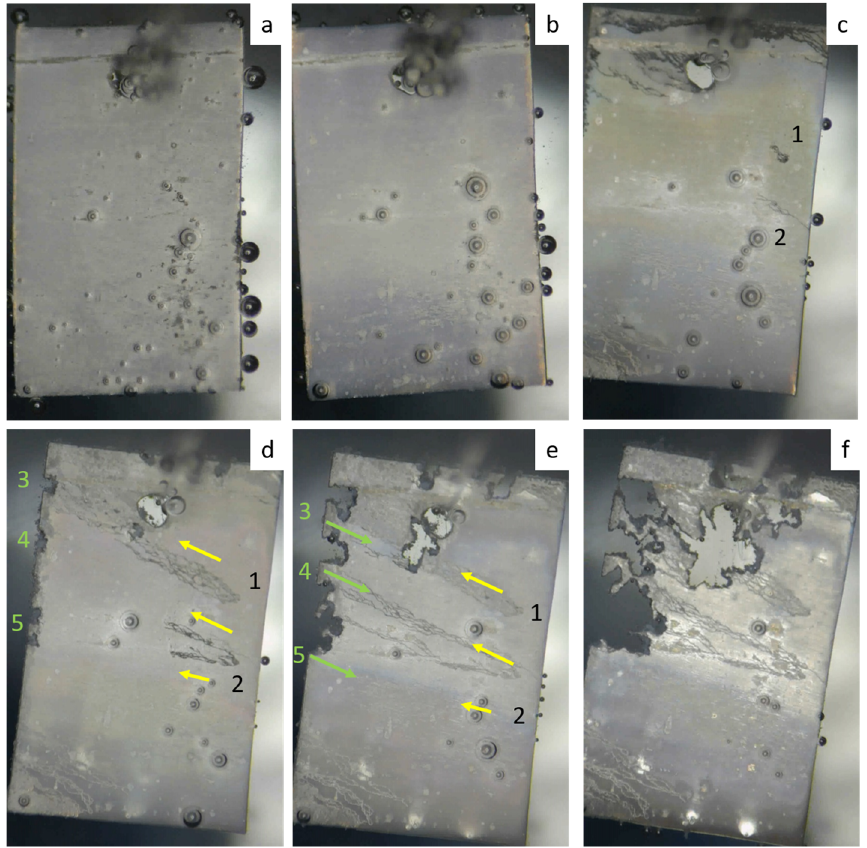
Figure 7. Evolution of the morphology of corrosion damage in the ZX10 alloy (( a )—after 30 min of the immersion test, ( b )—after 12 h, ( c )—after 24 h, ( d )—after 36 h, ( e )—after 48 h, ( f )—after 72 h).